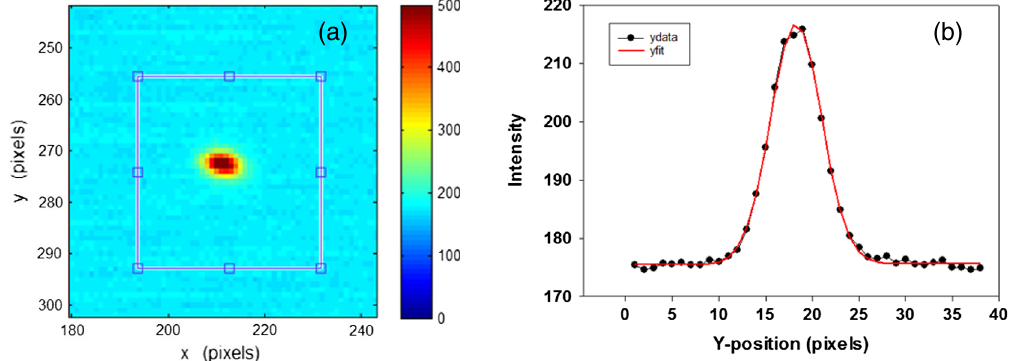
FIG. 6. (a) Focus mode image (sum of 2) and (b) projected y/time-axis profile data (black circles) with single Gaussian profile fit (red) with σ ¼ 2 . 5 pixels at 0.32 nC and 425 MeV. An intensity scale is given in the bar at the right of the image.